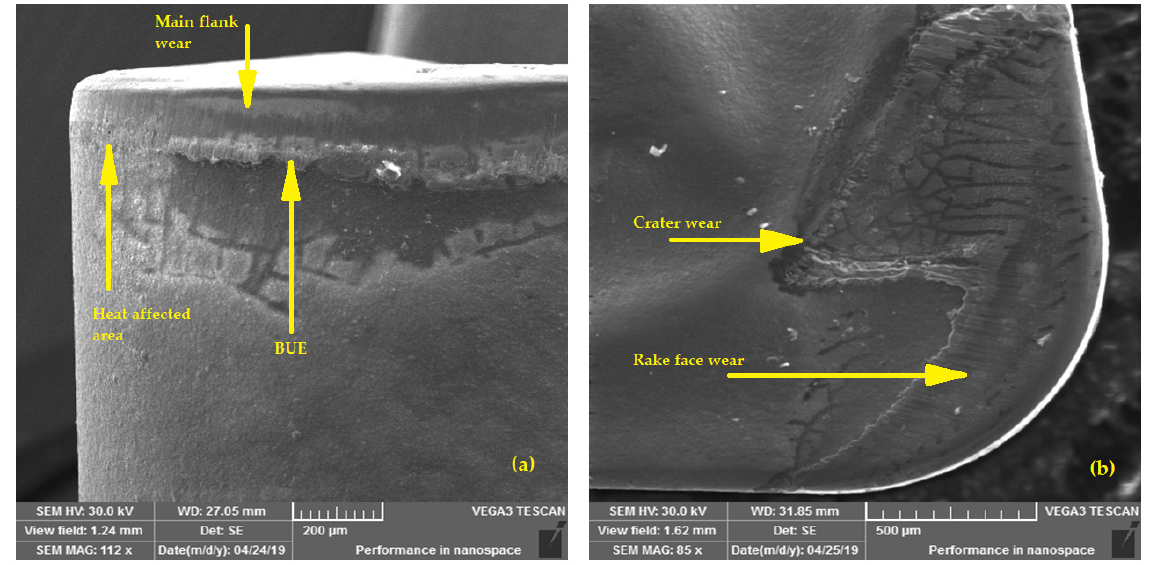
Figure 9. SEM analysis of wear of CNMG 120408E-M GRADE T9315: ( a ) main flank view, ( b ) rake face.